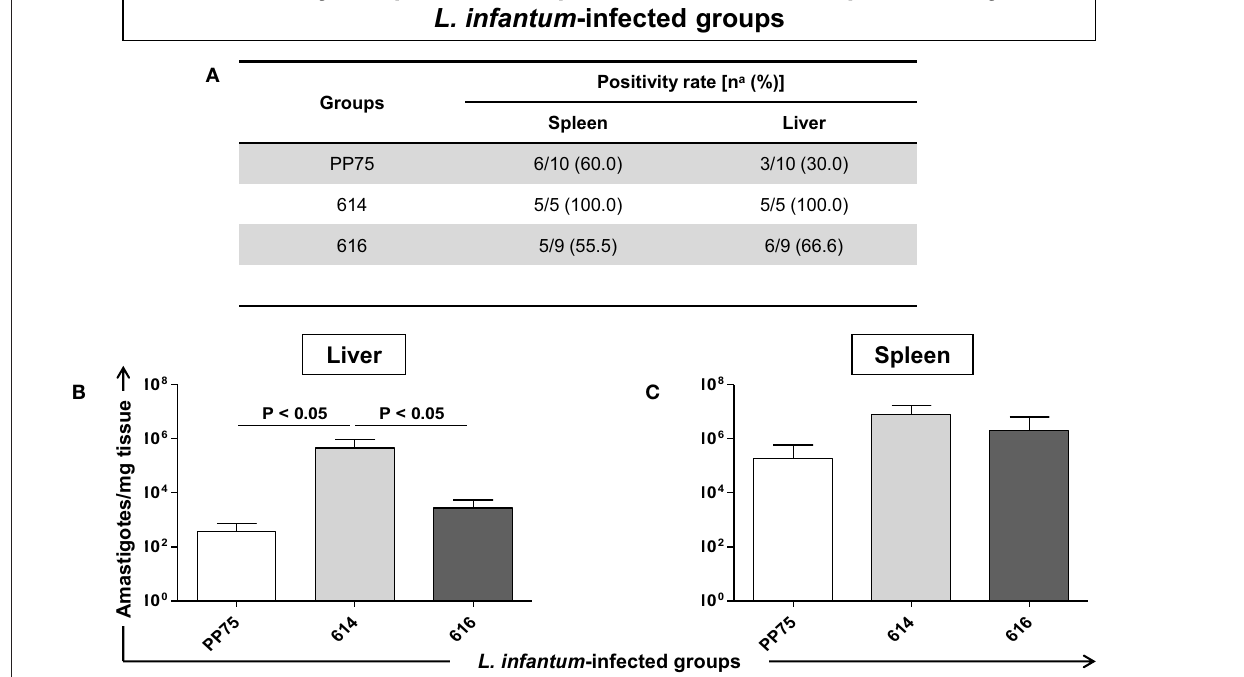
display distinct in vitro infectivity profiles, as observed in the present